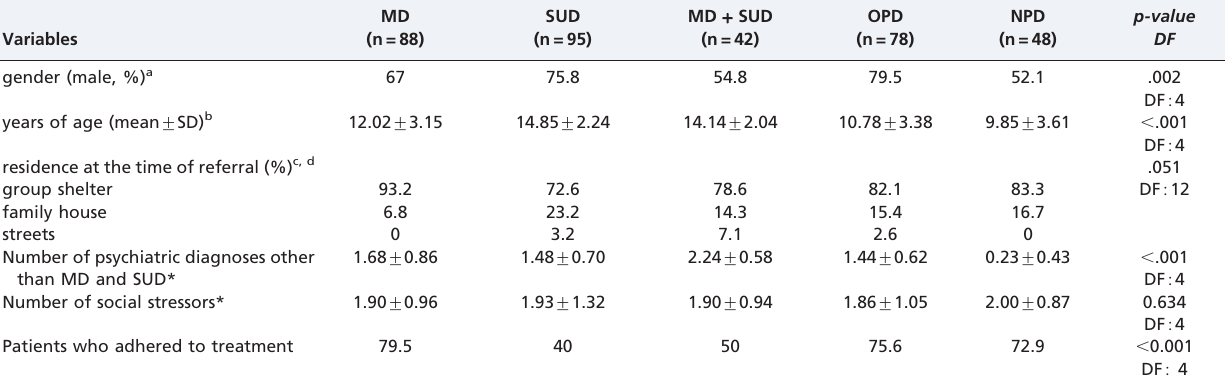
Table 1 - Socio-demographic characteristics of victimized children/adolescents attending a multidisciplinary treatment program (n= 351).